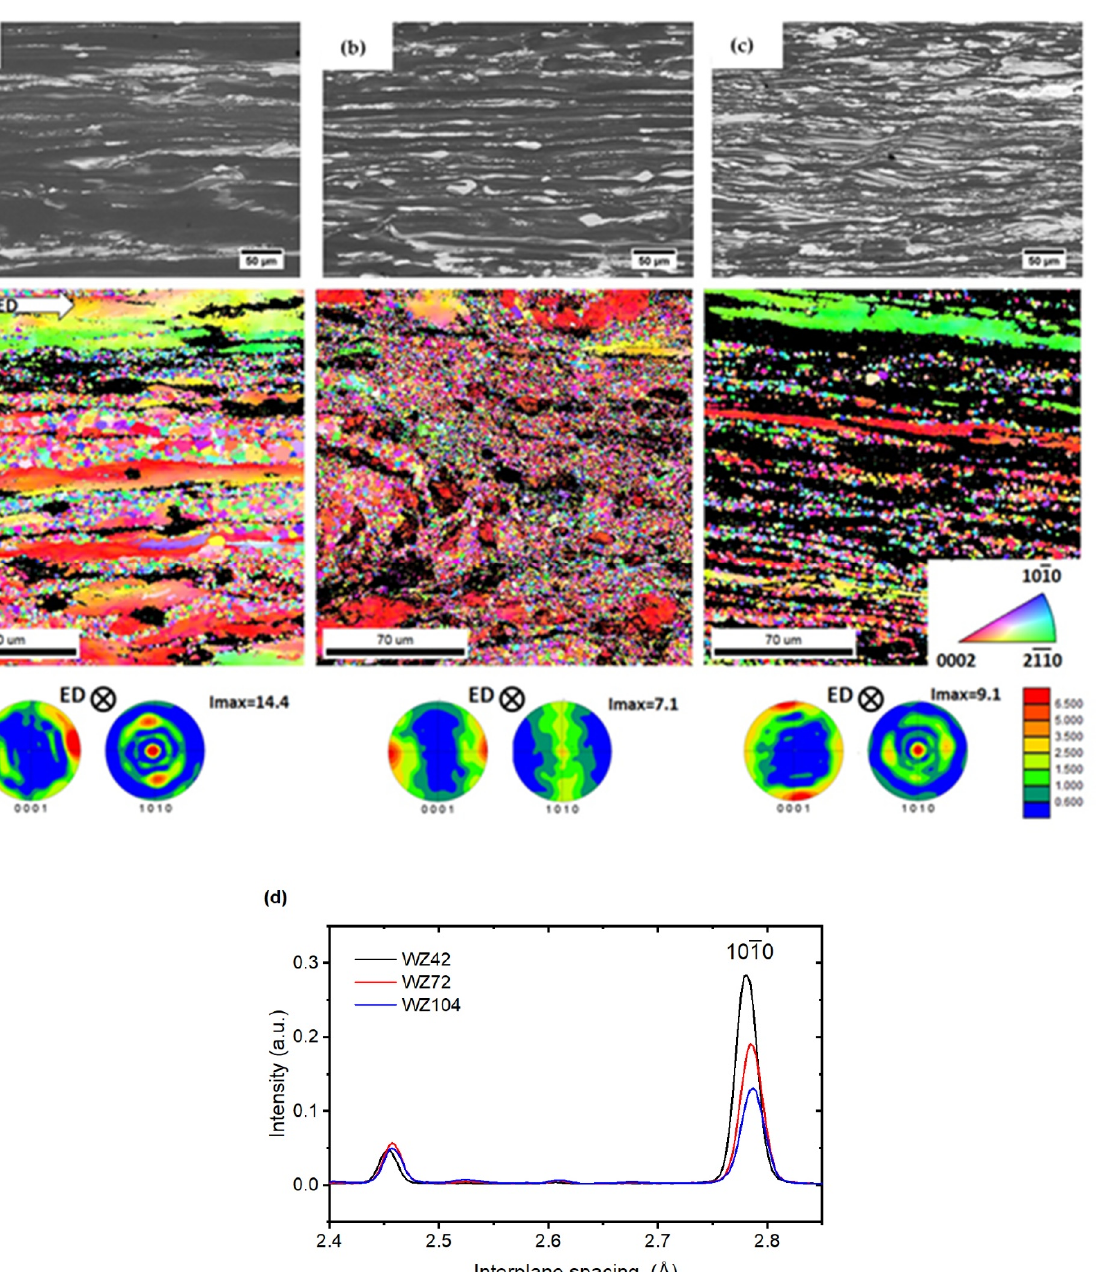
(cid:8) (cid:9) 1010 peak